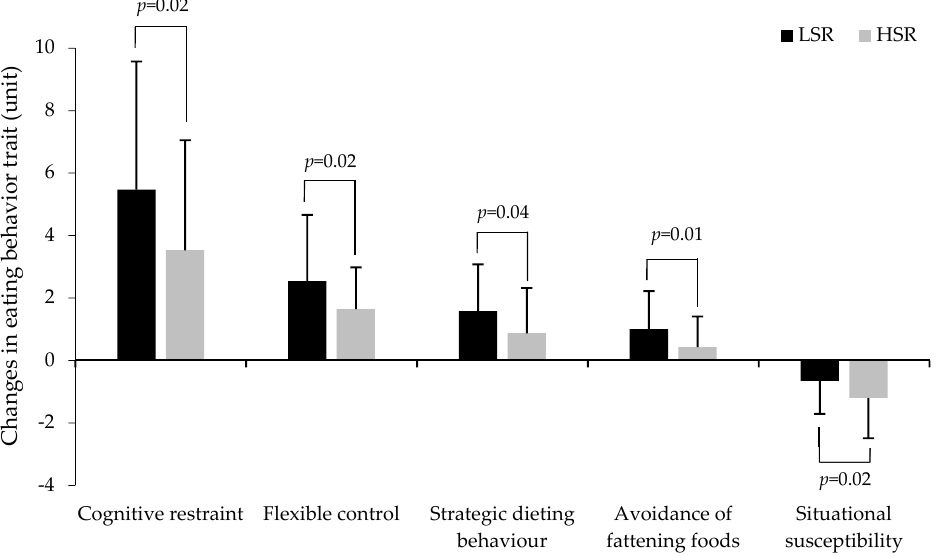
Figure 1. Changes in eating behavior traits in response to the weight loss intervention in the LSR group compared to the HSR group. LSR: Low satiety responsiveness, HSR: high satiety responsiveness ( n = 88 to 98). p values indicate a group by time interaction for changes in eating behavior traits in response to the intervention.